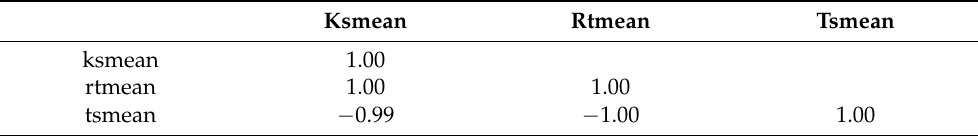
Table 6. Representation of the relationship between T-score, Round Time, Keystroke with Pearson’s correlation. Ksmean